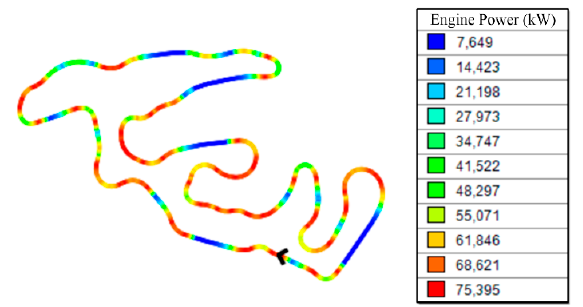
Figure 1. FSAE autocross Germany track simulation.